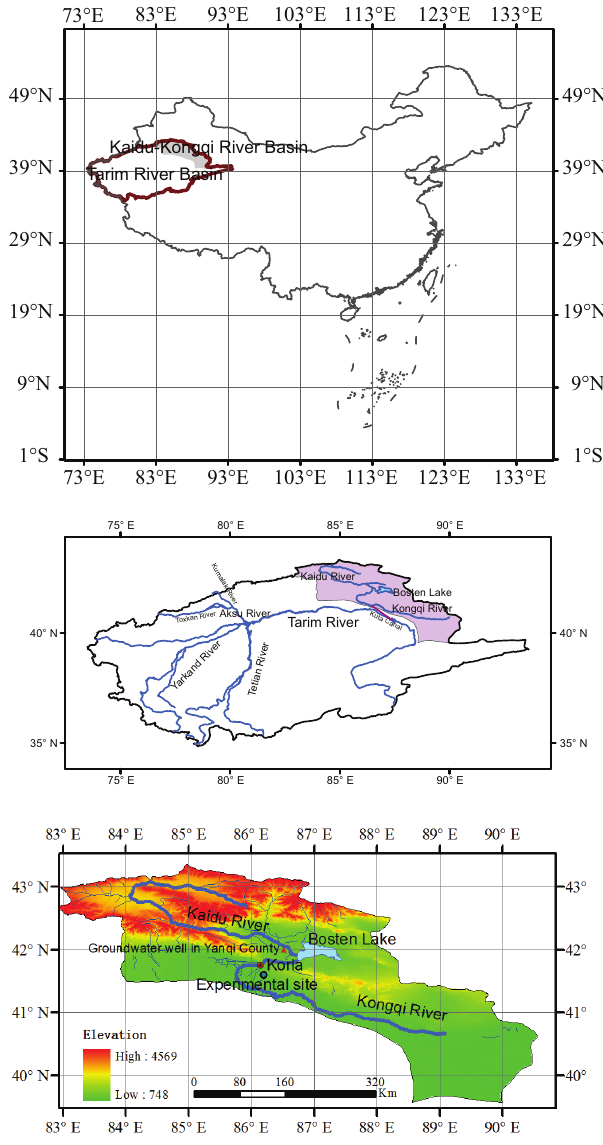
Figure 1. Geographic location of Tarim River basin and Kaidu– Kongqi River